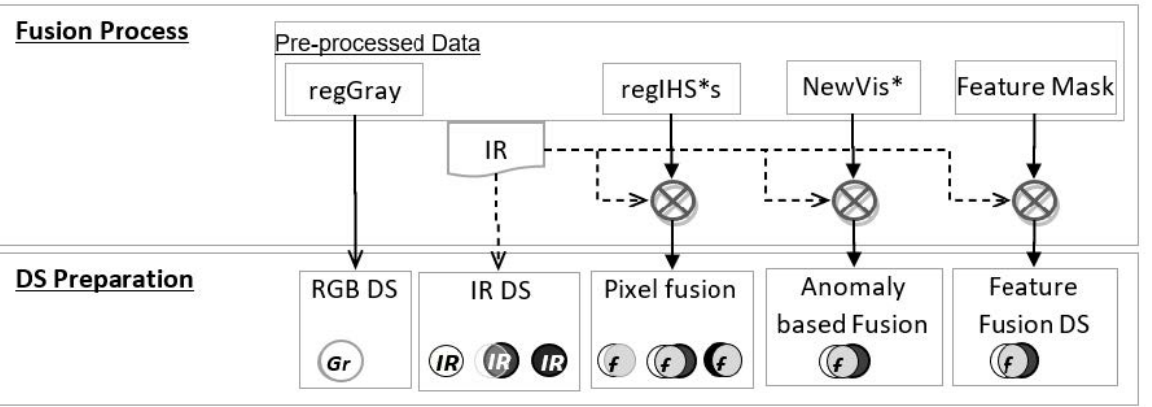
Figure 7. Fusion process schema and the resulting datasets for training, validating, and testing the networks.